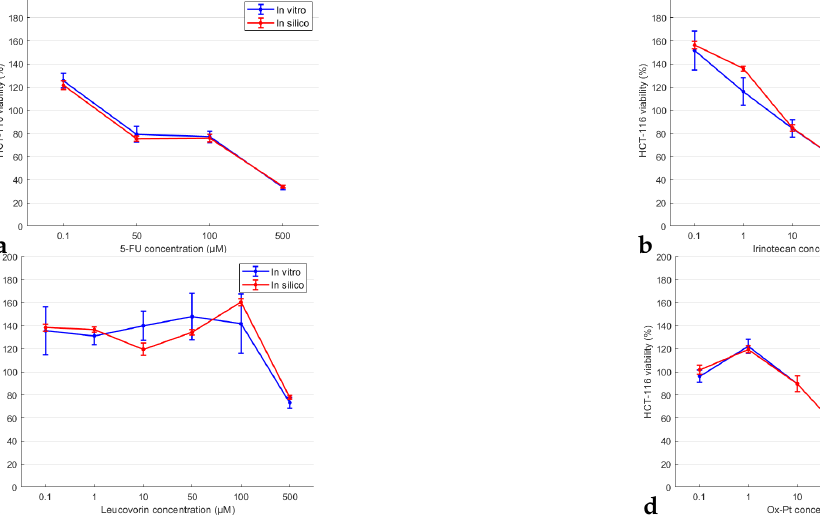
Figure 3. Comparison plots between the in vitro (blue lines) and the in silico (red lines) results after 72 h of HCT-116 cells’ incubation with respect to the drug type and concentration used per treatment